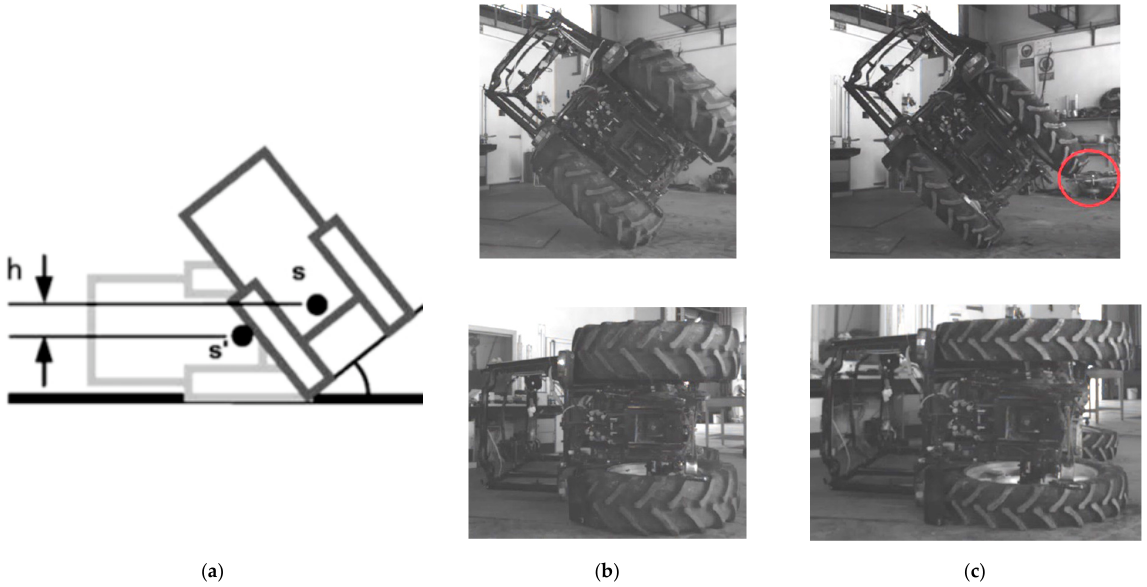
Figure 2. Lateral tractor rollover onto a horizontal surface: ( a ) Schematic representation where s , s’ indicate the COG initial and rest positions respectively; actual tested tractor in T1 ( b ) and T2 ( c ) configuration. Table 1. Main physical parameters of the modified tested tractor in the T1 and T2 configurations.